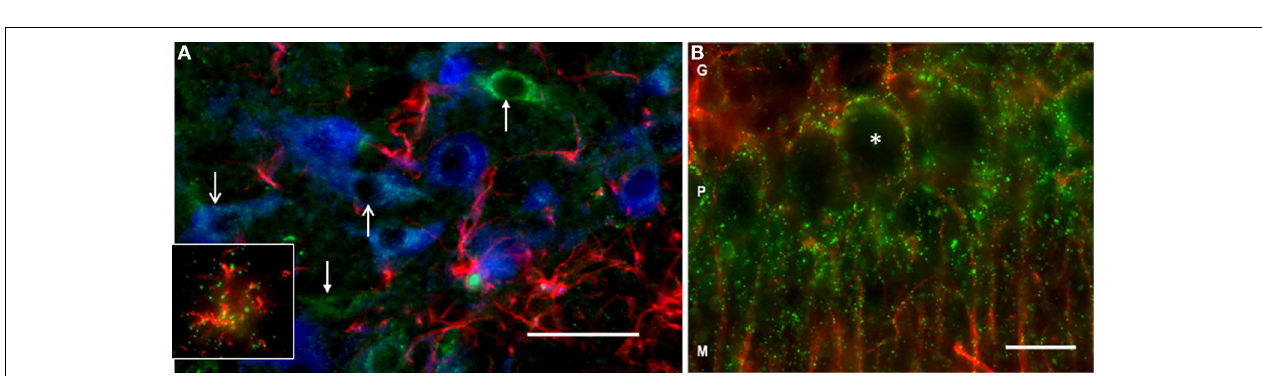
of background signal. (D) Cerebellum, showing DAO mRNA concentrated in the Purkinje cell layer (P) with moderate signal in the granule cell layer (G) and low signal in the molecular layer (M). (E) Cerebellum, sense strand hybridization control. Sections are counterstained with cresyl violet.